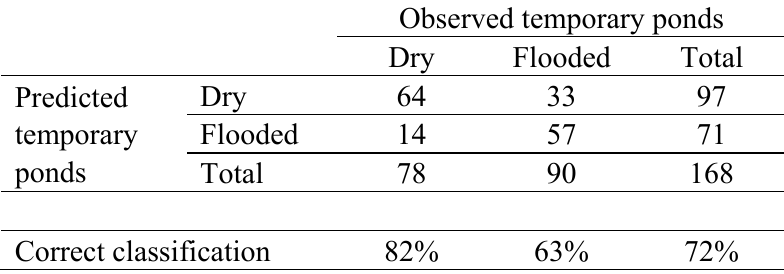
Table 3. Confusion matrix showing the correspondence between ground-truth-assessed temporary ponds and the flooding status predicted with the GLM models after applying the zero-threshold value both for observed and predicted values of pixel flooding (flooded pixel: fraction of water cover ≥